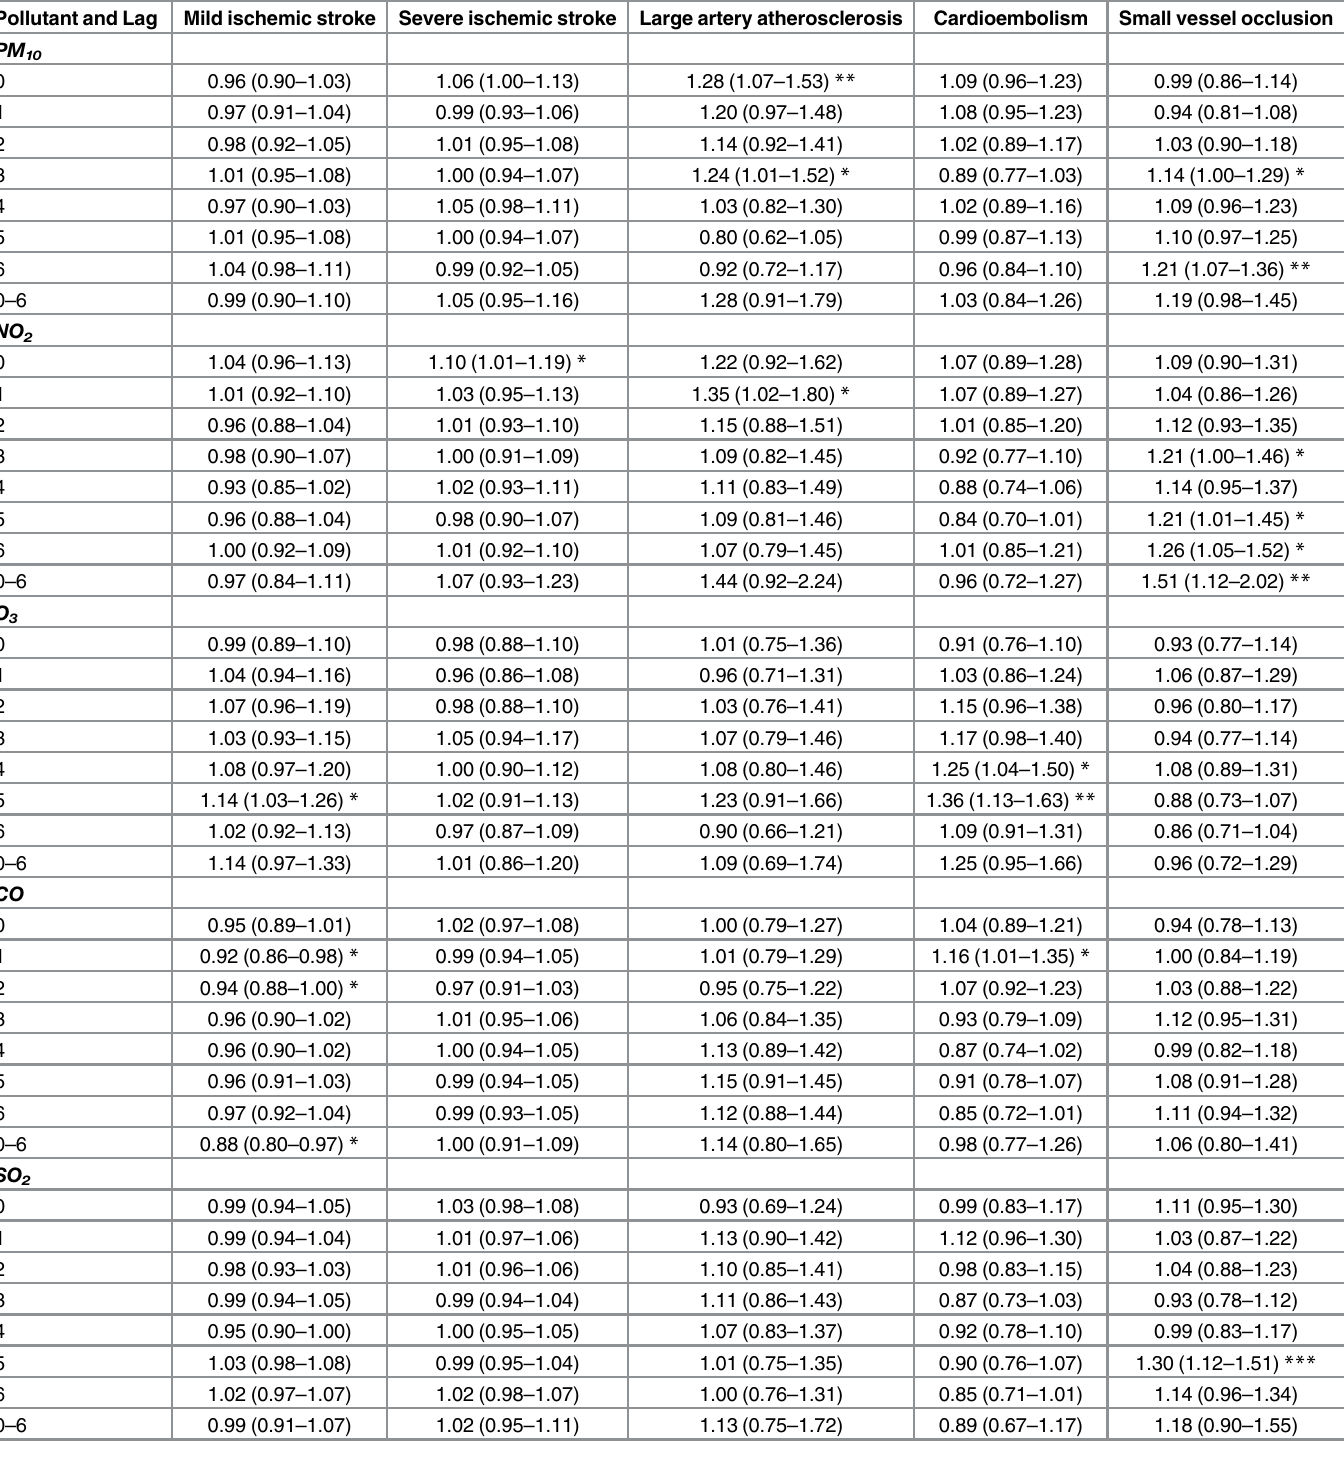
Table 4. Adjusted odds ratios (95% CI) for mild and severe ischemic stroke and ischemic stroke classified by etiological (TOAST) subtype associ- ated with an inter-quartile range increase in outdoor air pollutants by lag interval, South London Stroke Register 1995 –